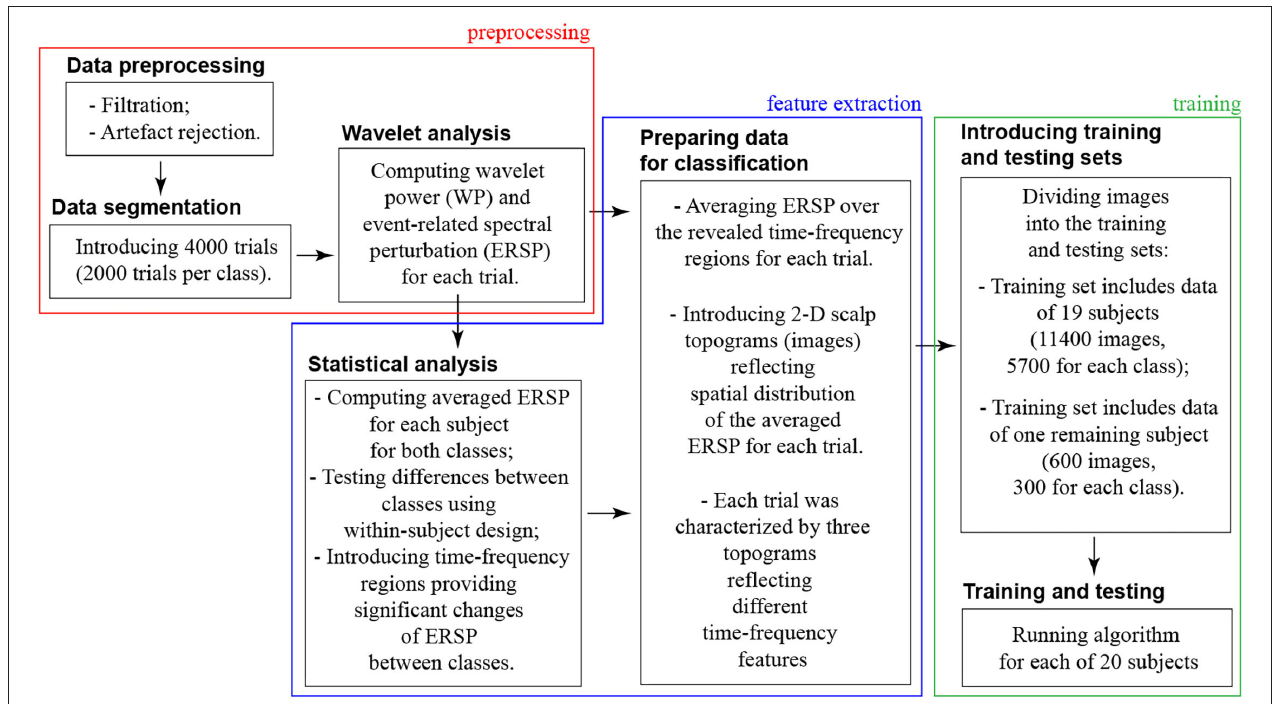
FIGURE 2 | Scheme of the data processing